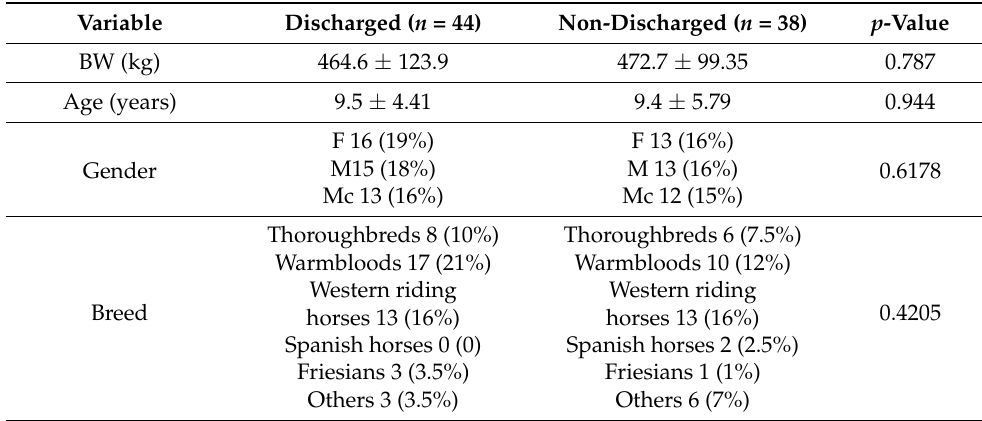
Table 7. Comparison of signalment findings in discharged and non-discharged horses that received a surgical treatment (BW: body weight; F: female; M: stallion; and Mc: gelding).